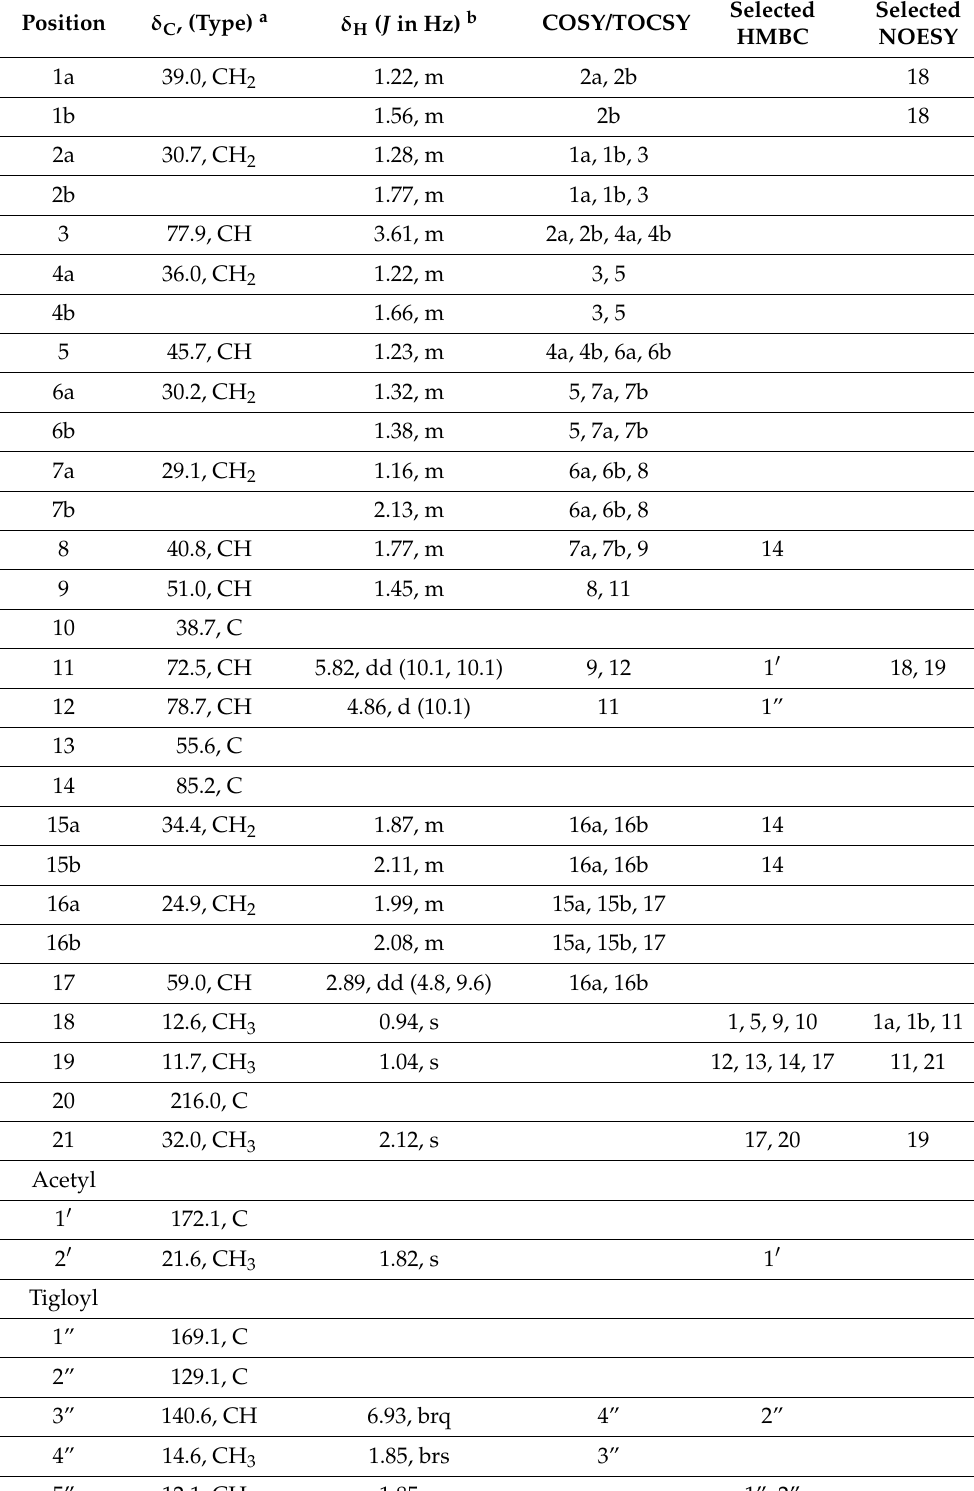
Table 2. NMR data of the active compound in CD 3 OD. Position COSY/TOCSY